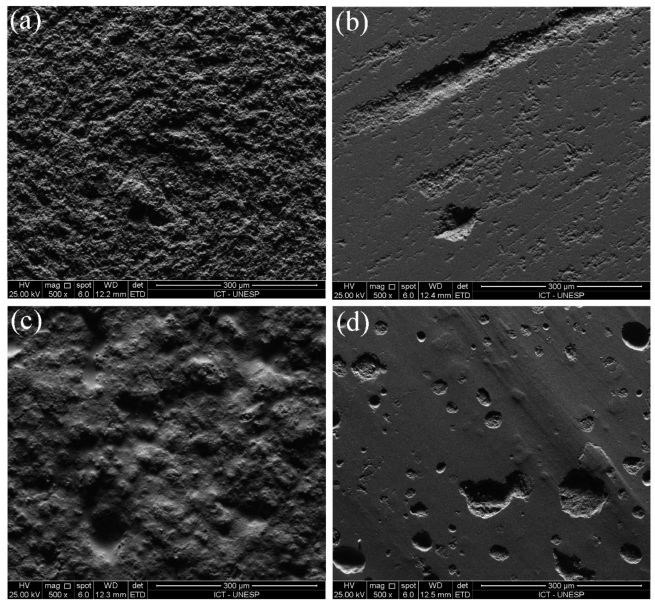
Figure 5. SEM images of PICN ( a , b ) and steatite antagonists surfaces ( c , d ) at 500 × magnification, before (left) and after (right) the wear simulation. Uneven surfaces were observed before the tests, which turned more homogeneous after